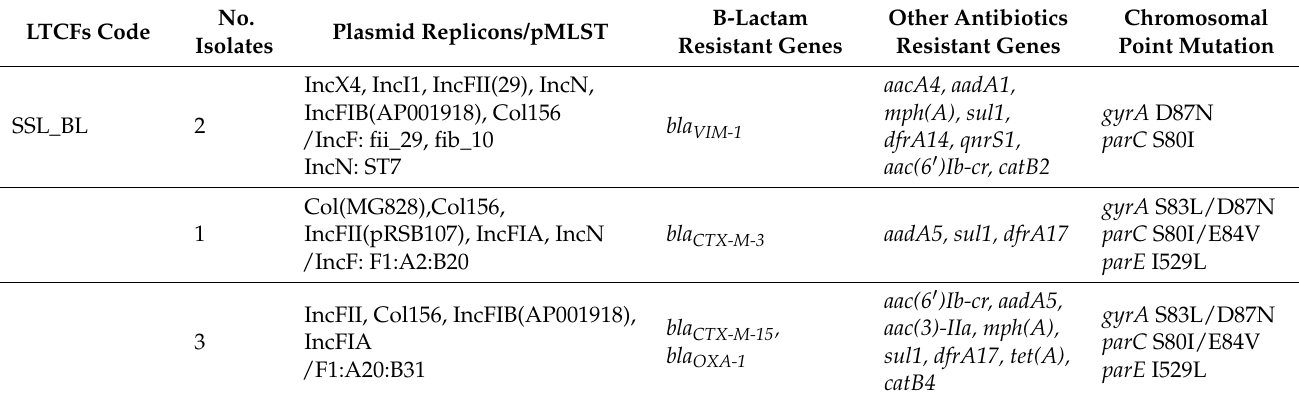
Table 3. Resistome pattern of E. coli isolates from LTCFs in Northern Italian